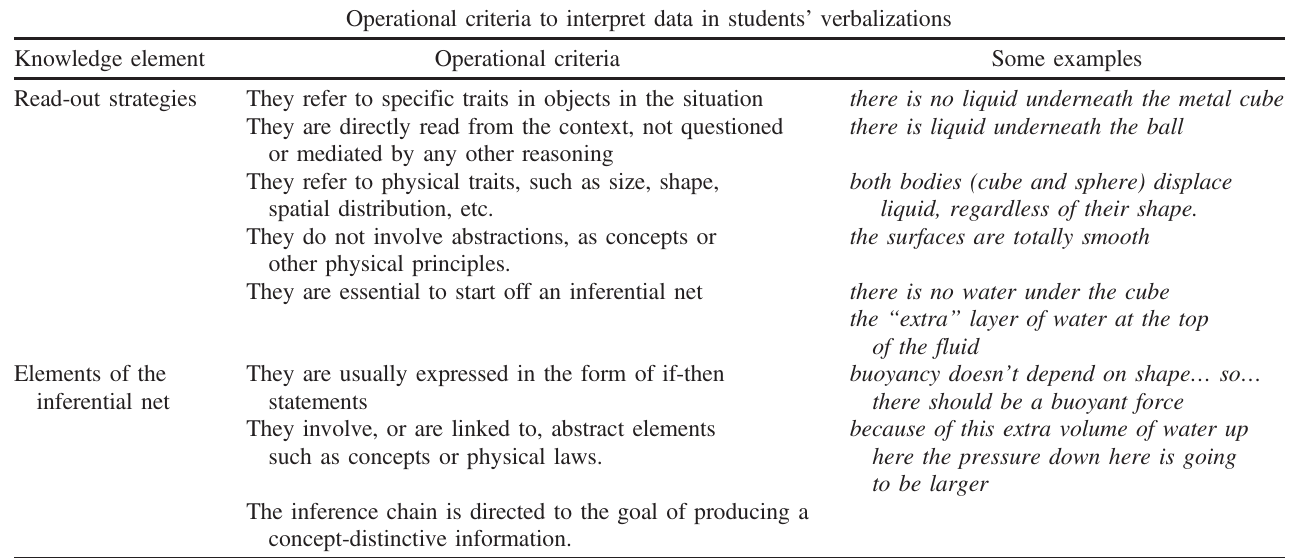
TABLE I. Operational definitions for read-out strategies and elements of the inferential